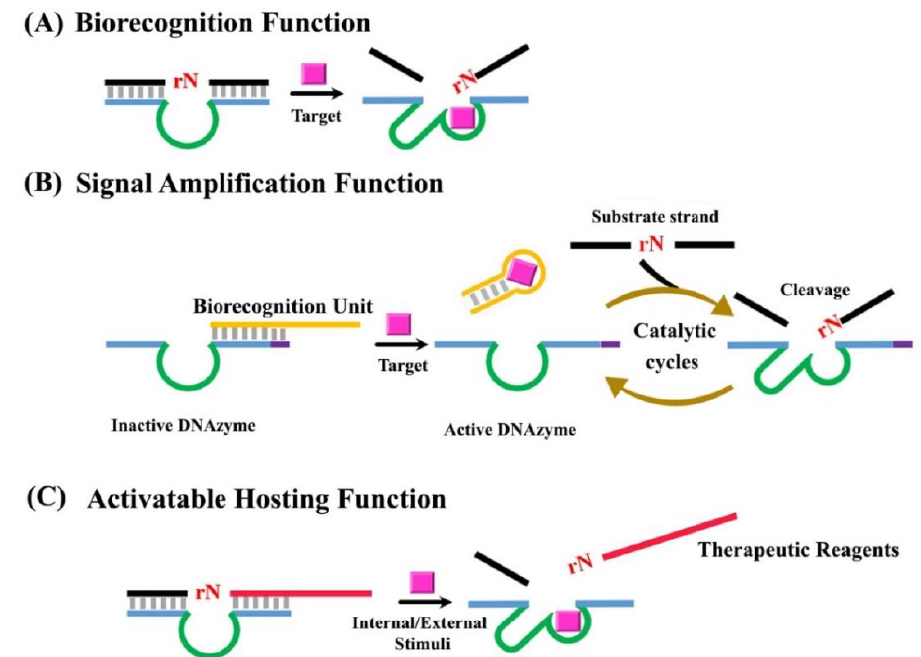
Figure 3. A summary of the general concept of translating RNA-cleaving DNAzymes into functional probes.